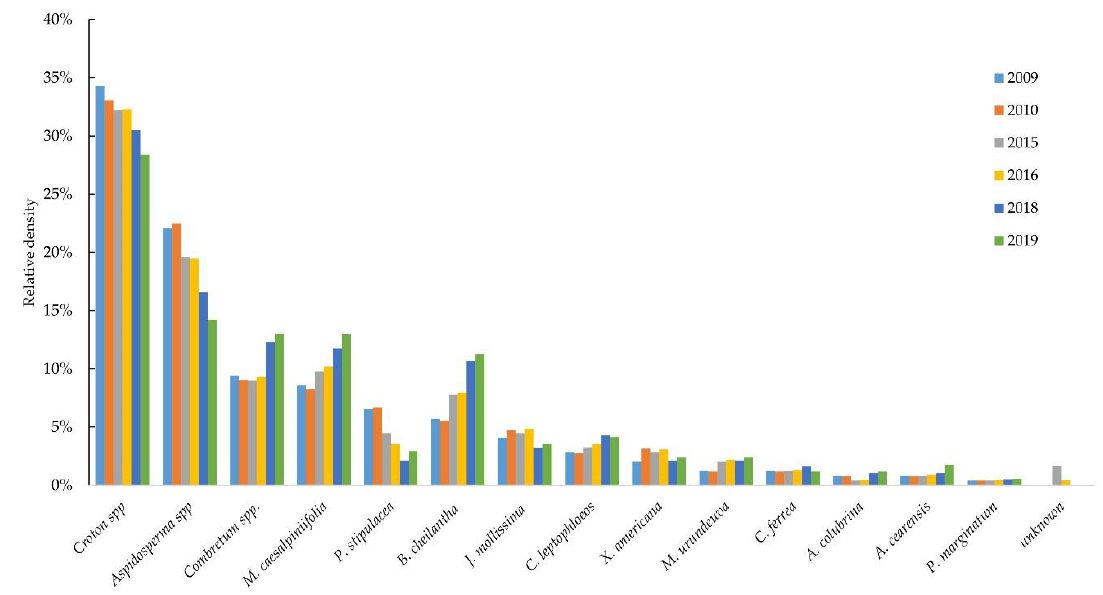
Figure 4. Annual distribution of species density in a fragment of dry tropical forest under preservation for approximately 40 years, in the district of Iguatu, Ceará, Brazil.